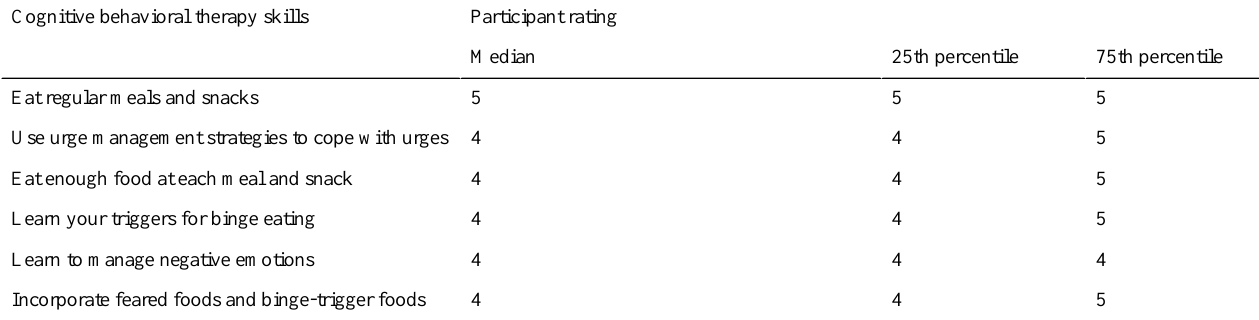
Table 2. Median patient ratings of the usefulness of CBT+ for the acquisition of each cognitive behavioral therapy skill.